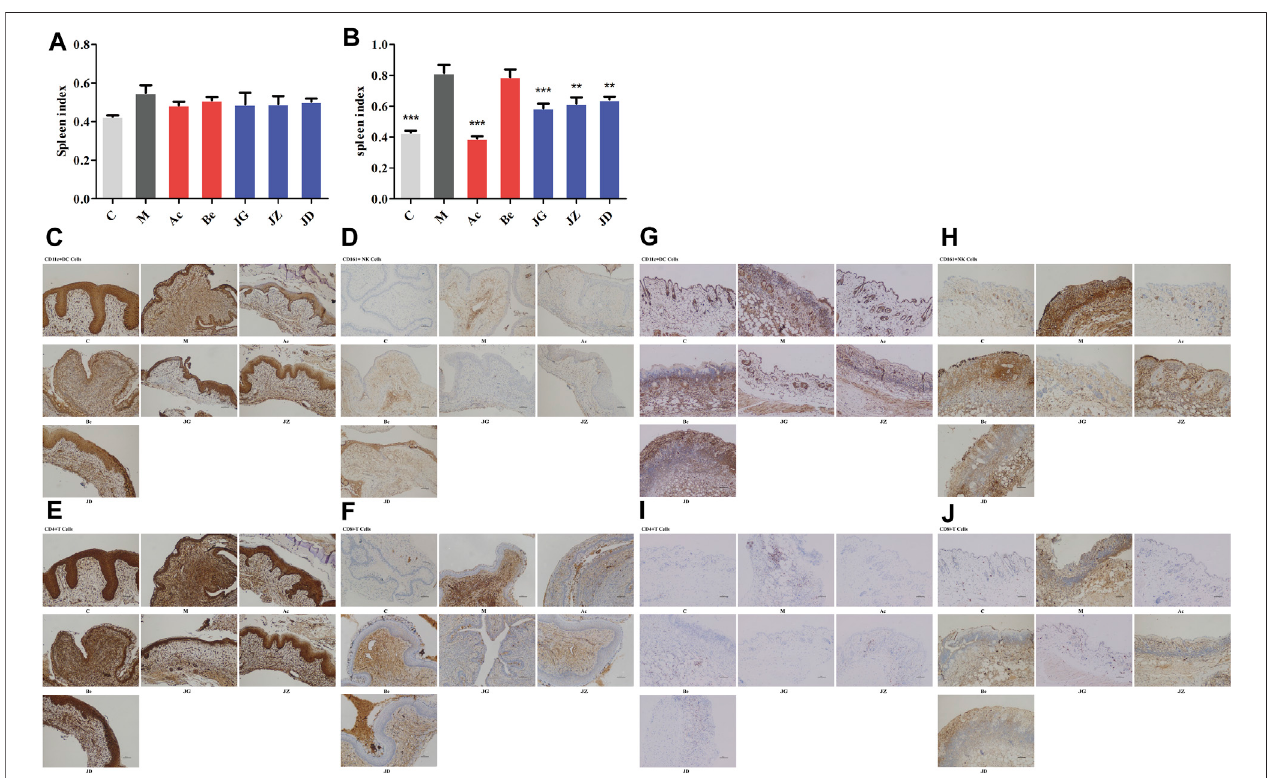
FIGURE10| Effect ofJZ-1ontheimmuneresponseofGHmice.On12 h (A) andday 9 (B) after modeling,thespleenindexofGHmicewasmeasured.Moreover, theimmunecellin fi ltrationinvaginal (C – F) andvulvar (G – J) tissuesofGHmiceonday9weredetectedbyimmunohistochemistrystaining.JZ-1reducedthespleenindex and in fi ltrationofimmunecells.C,controlgroup;M,modelgroup;Ac,acyclovirgroup;Be,berberinegroup;JG,JZ,JD:2.5,1.5,and 0.5 g/mlJZ-1group. *p ＜ 0.05, **p ＜ 0.01, ***p ＜ 0.001 vs. M